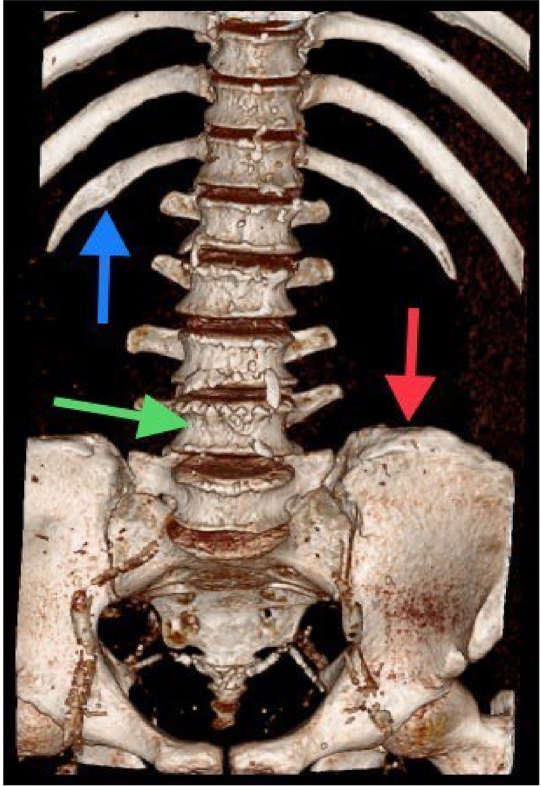
Fig. 4 Volumetric image of bone window MDCT illustrates the hypertrophied left pelvic bones (red arrow), degenerative changes in the spine (green arrow), and normal ribs (blue arrow) and right-side pelvic